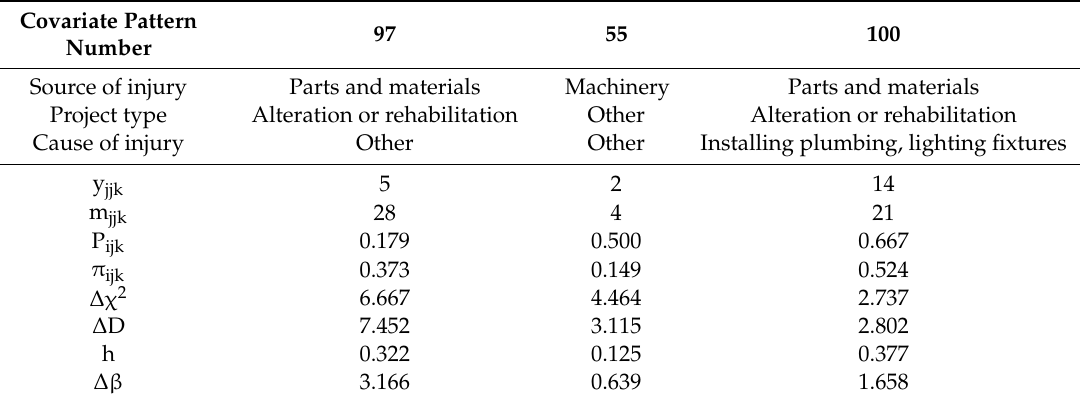
Table 6. Covariate values, observed outcomes (y ijk ), number of cases in the covariate pattern (m ijk ), observed probability (P ijk ), estimated logistic probability ( π ijk ), and the value of four diagnostic statistics ∆ χ 2 (i.e., change in value of the Pearson chi-square), ∆ D (i.e., change in the deviance), h (i.e., leverage), and ∆ β (i.e., change in value of the estimated coe ffi cients), for three covariate patterns with at least one large diagnostic value.